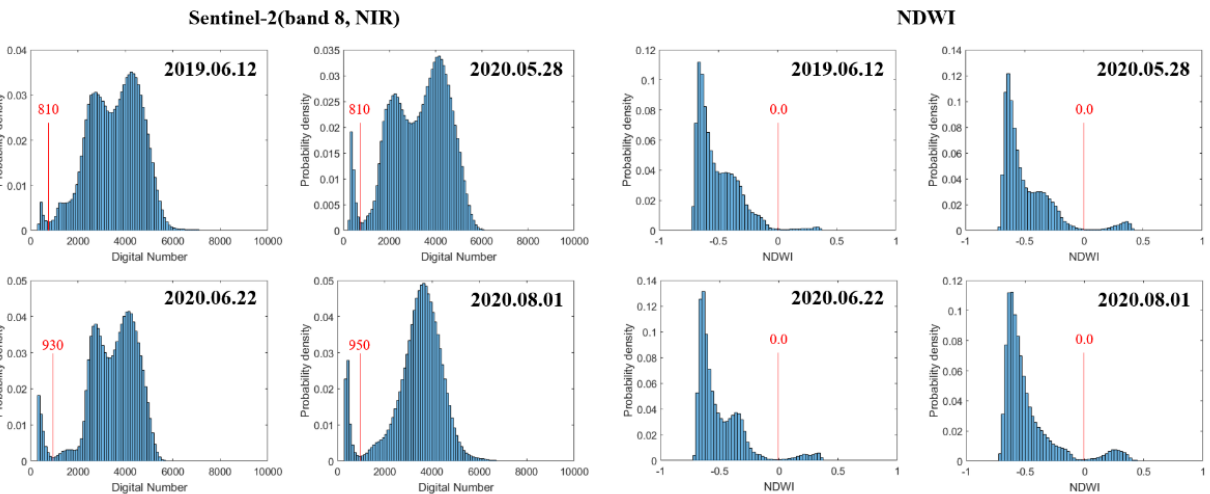
Figure 7. A comparison of the histograms for Sentinel-2 (Band 8) ( left ) and NDWI ( right ) images; highlighted number represents a threshold of the water body.